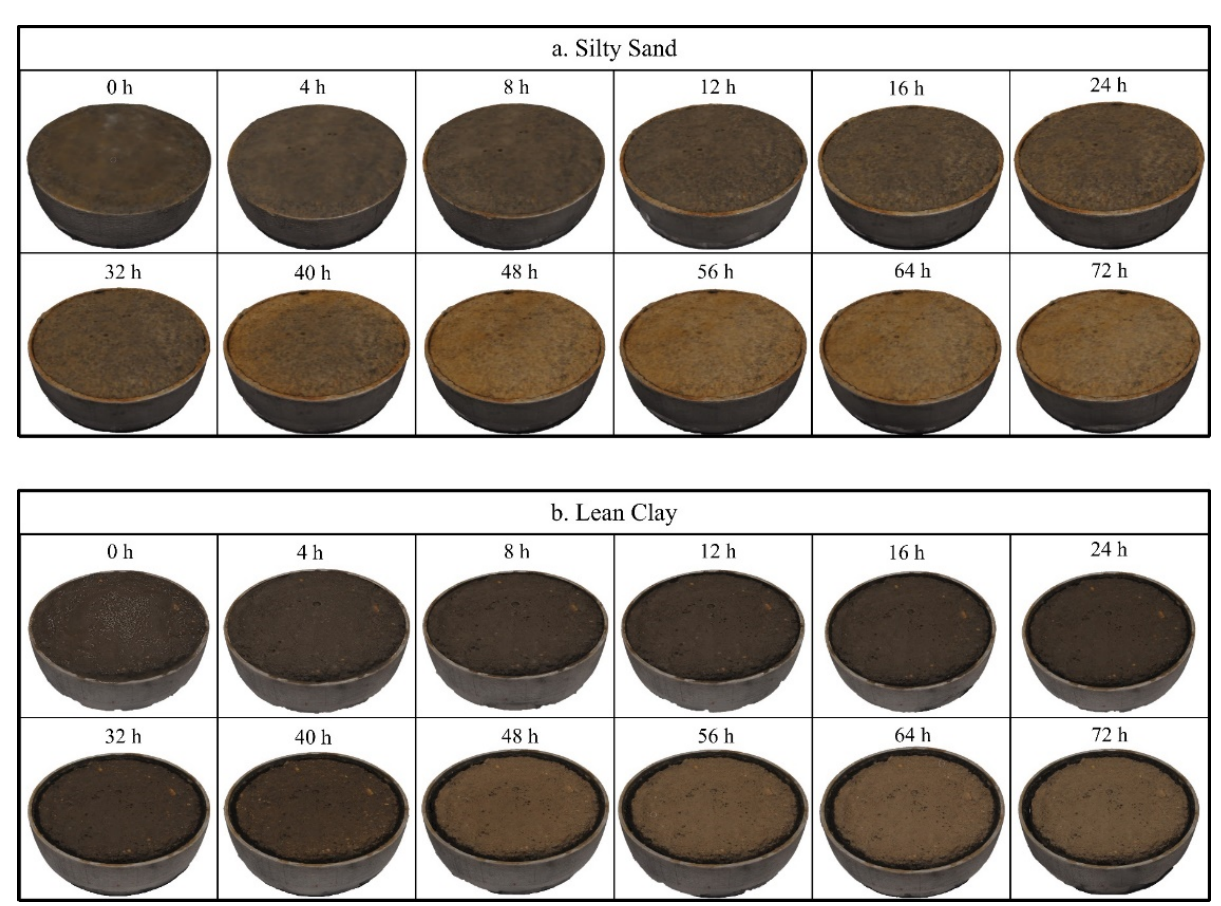
Figure 4. Three-dimensional models of the investigated soils during drying under laboratory ambient conditions: ( a ) silty sand; and ( b ) lean clay.